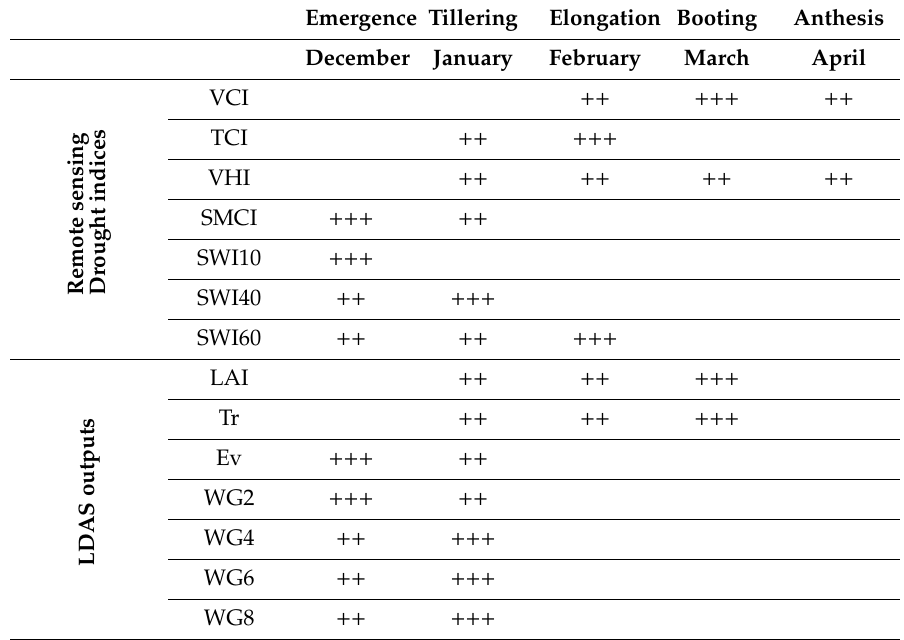
Table 9. Summary of the linkages between the remote sensing drought indices, the LDAS output variables and the cereal yields during the crop season ( ++ significant correlation, +++ highly significant